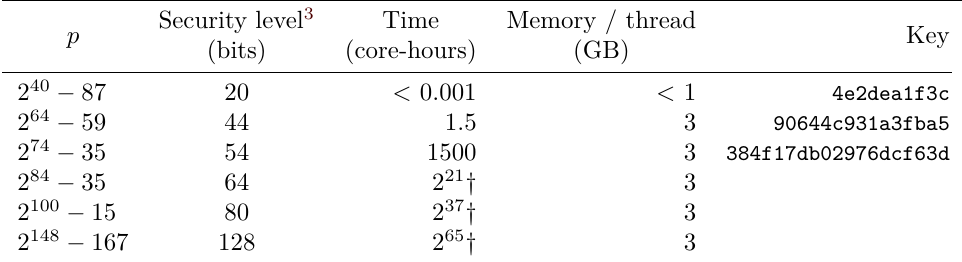
Table 2: Parameters of the concrete challenges proposed by the Ethereum founda- tion [Fei19b]. For all instances, the first M = 2 20 consecutive PRF outputs were given. For the first three instances, the running time and peak memory usage is given, for the three hardest instances an estimation of time is provided (marked by † ). All experiments were performed on a Dell C6420 server with two Intel Xeon Gold 6132 CPUs clocked at 2.6 GHz and 128 GB of